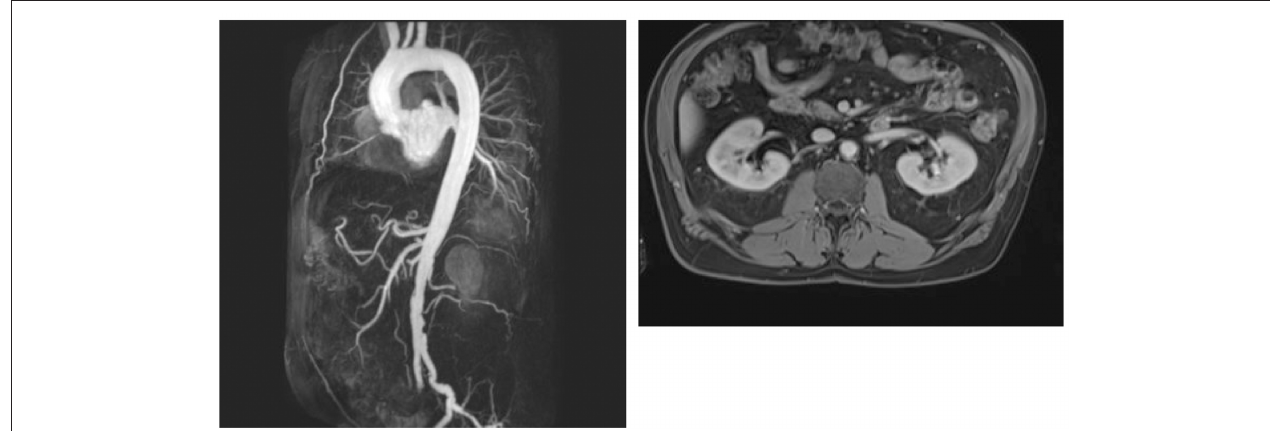
FIGURE 3 | MIP reconstruction of a CE-MRA of a 64 years old patient’s aorta and transversal T1 vibe dixon with excentric plaque of the aorta. Pictures by courtesy of Dr. med. Corinna Schorn, Rheumatology center in Bad Kreuznach,